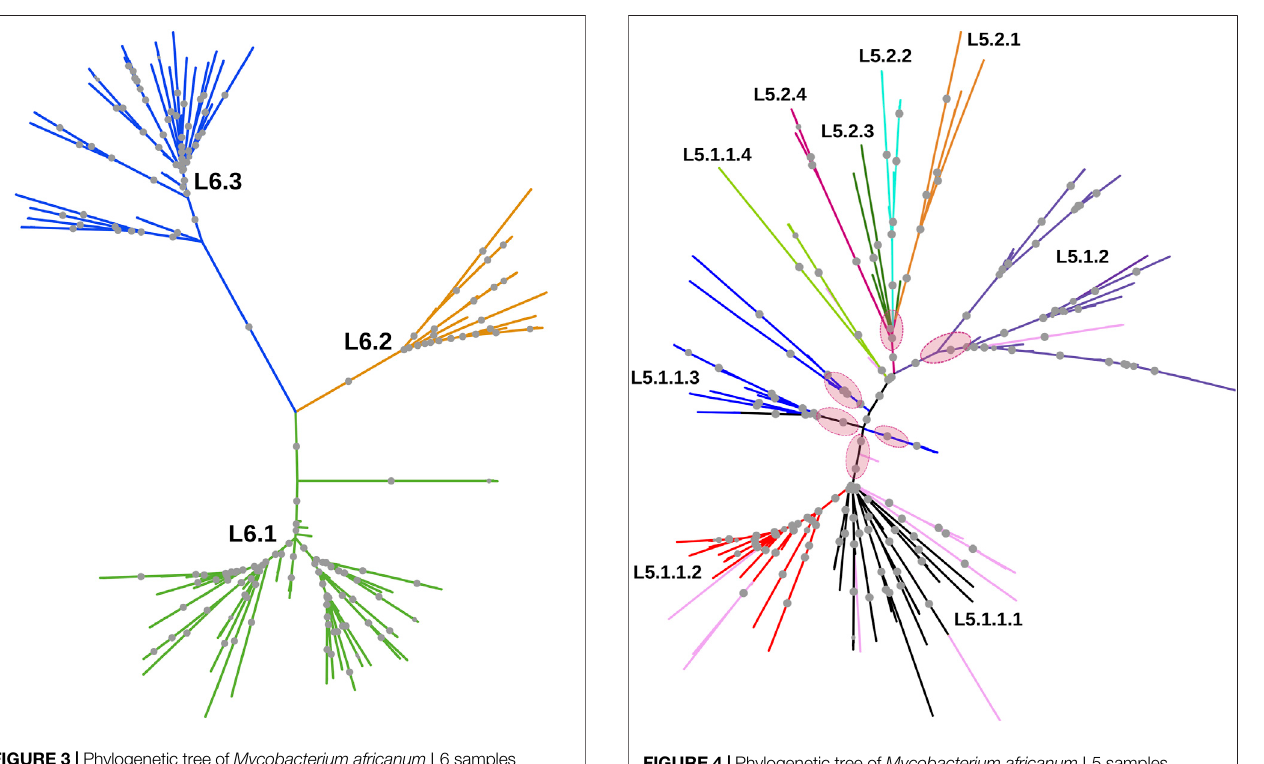
FIGURE 4 | Phylogenetic tree of Mycobacterium africanum L5 samples derived using the maximum likelihood method, as implemented in RAxML based on genome-wide SNPs. Pink circles represent the six major monophyletic clustersobserved. Samplesmarkedinlightpinkrepresent